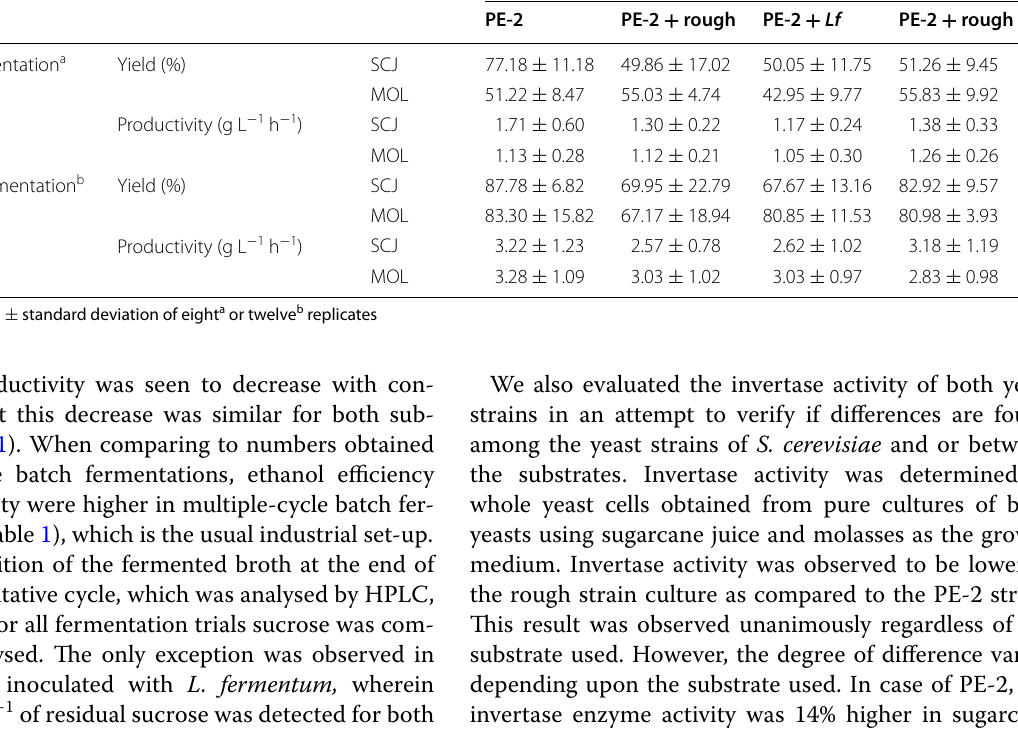
Table 1 Ethanol yield (%) and ethanol productivity (g L − 1 h − 1 ) of the fermentations carried out with the industrial S. cere- visiae yeast (PE-2) contaminated with the rough strain of S. cerevisiae (rough) and/or L. fermentum (Lf), in sugarcane juice (SCJ) or molasses (MOL) at 30 °C, in single and multiple-batch fermentations